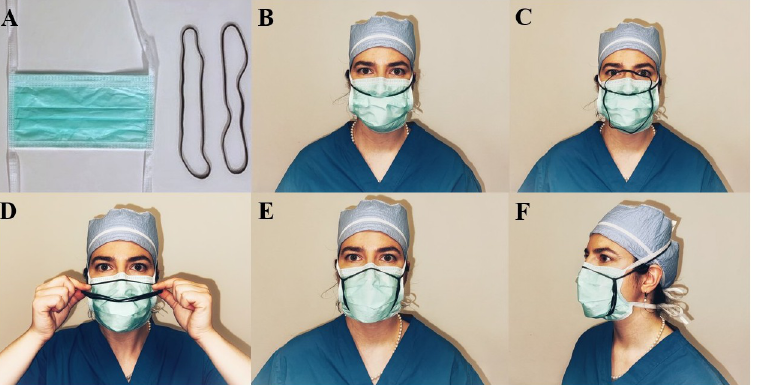
Fig 1. Demonstration of the assembly of the modified mask. Photographs of the simple modification demonstrating an individual properly donning the modified mask. (A) Modified mask components consist of a standard ASTM Level 1 surgical mask and two 8” rubber bands. (B) While wearing an ASTM Level 1 surgical mask which has been adjusted to fit along the bridge of the nose, apply one 8” rubber band along the crown of the head and place the front of the rubber band under the nose. (C) Take another 8” rubber band and apply it perpendicularly under the first rubber band so that two loops are formed above and below the first rubber band. (D) Shift the first rubber band so that it is over the bridge of the nose and fold the second rubber band in half on itself along the first rubber band on the horizontal axis. € Place the second rubber band along the cheeks and under the chin. Adjust both rubber bands as needed to achieve a full seal as shown in this anterior view of the final construct. (F) Lateral view of the final